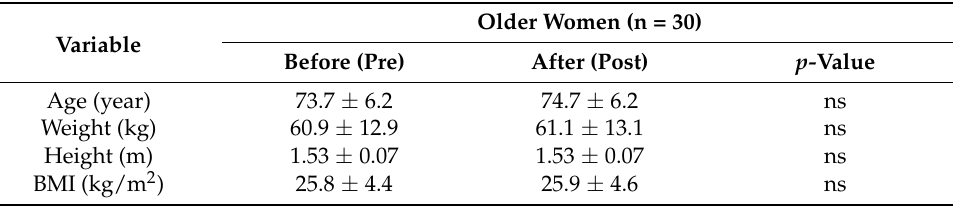
Table 1. Anthropometric data (age, weight, height, and BMI), mean, and standard deviation (SD) of older women volunteers participating in the